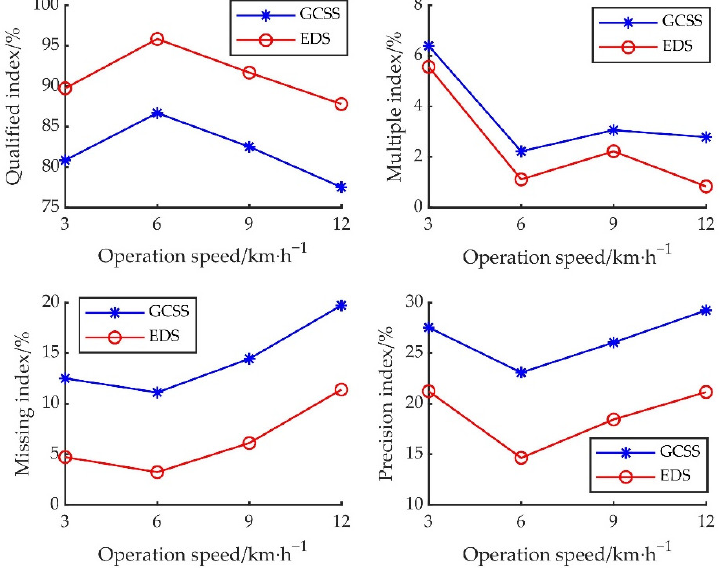
Figure 10. Comparison of seeding performance between GCSS and EDS. The electric-driven mung bean air suction precision seed metering device control system based on GAPSO-Fuzzy-PID can effectively reduce the missing index and precision index of the original seed metering device control system, reduce the system’s false